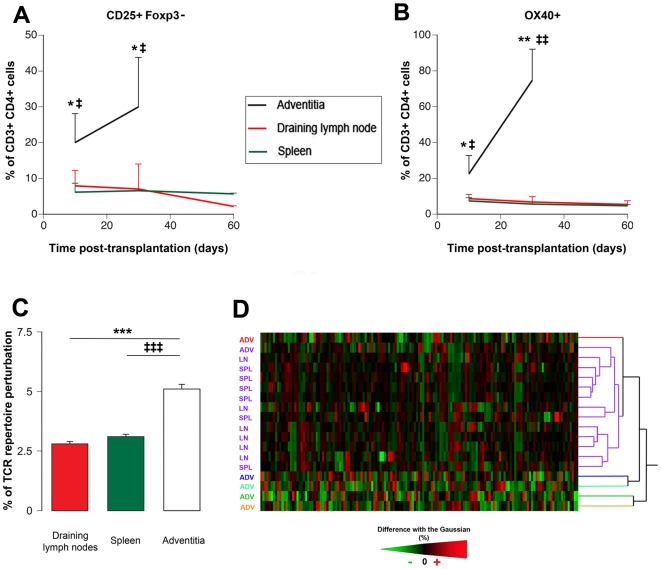
Characteristics of the T helper response in the various lymphoid organs participating in chronic rejection.
A. B. The percentage of activated T lymphocytes was evaluated by: A. the expression of the α chain of the IL2 receptor (CD25), and B. the costimulatory molecule OX40 (CD134). Adventitia vs spleen: ‡ p<0.05, ‡‡ p<0.01; adventitia vs draining lymph node: * p<0.05, ** p<0.01. C. D. The TCR repertoire perturbations induced by chronic rejection in the spleen, the draining lymph nodes and the adventitial TLT were analyzed using the immunoscope method. Immunoscope divides T cell population into 180 “groups” defined upon the rearranged variable ß (Vß) gene segment used, and the length of the TCR CDR-3. In baseline conditions, the distribution profile of CDR3 lengths for each Vß family displays a Gaussian distribution. An increase in the height of a size peak signals an oligoclonal or a monoclonal expansion of this group that can be reliably quantified by the percentage of difference between the measured value the expected normal value. C. The mean percentage of perturbation for the 180 groups is shown for each lymphoid organ. Adventitia vs spleen: ‡‡‡ p<0.001; adventitia vs draining lymph node: *** p<0.001. D. The set of data was computed to group samples according to their pattern of TCR repertoire perturbation (Ward hierarchical clustering). Individual samples are listed in raw (ADV: adventitia; LN: draining lymph node; SPL: spleen), the 180 groups constituting the T cell population are in column. Perturbations are encoded from light green to bright red. On the right of the color map, a dendrogram list each observation, and shows which cluster it is in and when it entered its cluster.